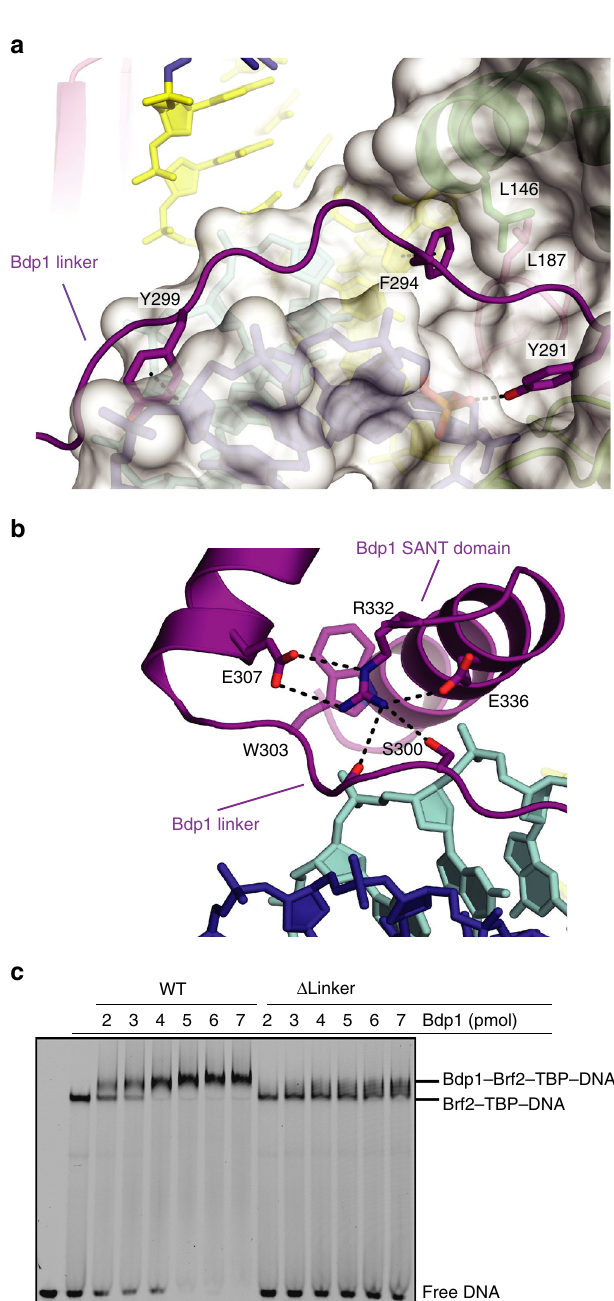
Fig. 4 Characterization of the Bdp1 linker. a The Bdp1 linker invades the DNA minor groove and interacts with the DNA through aromatic residues. Color scheme as in Fig. 1c; the TATA box is depicted in yellow . b The Bdp1 linker interacts with the SANT domain throughout conserved polar residues. Color scheme as in Fig. 1c. c EMSA showing reduced binding of Bdp1 Δ linker mutant to Brf2 – TBP – DNA alter the bending state of the DNA, suggesting that Bdp1 binds to the stable pre-bent Brf2 – TBP – DNA complex resulting in extremely stable complexes bound to the DNA.